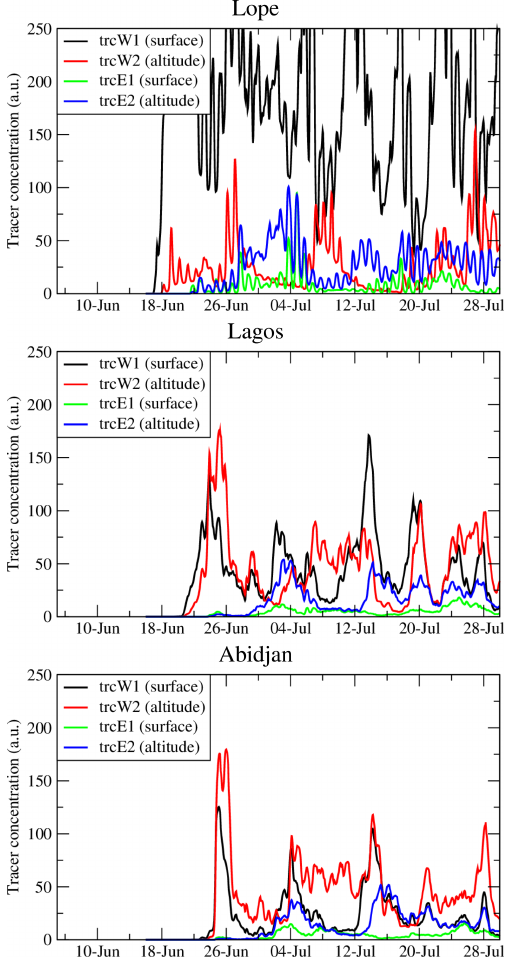
Figure 3. Time series of surface concentrations (arbitrary units) in Lope, Lagos, and Abidjan for the four tracer releases from 15 June to 31 July 2014 and close to the most important biomass burning emission areas observed in Central